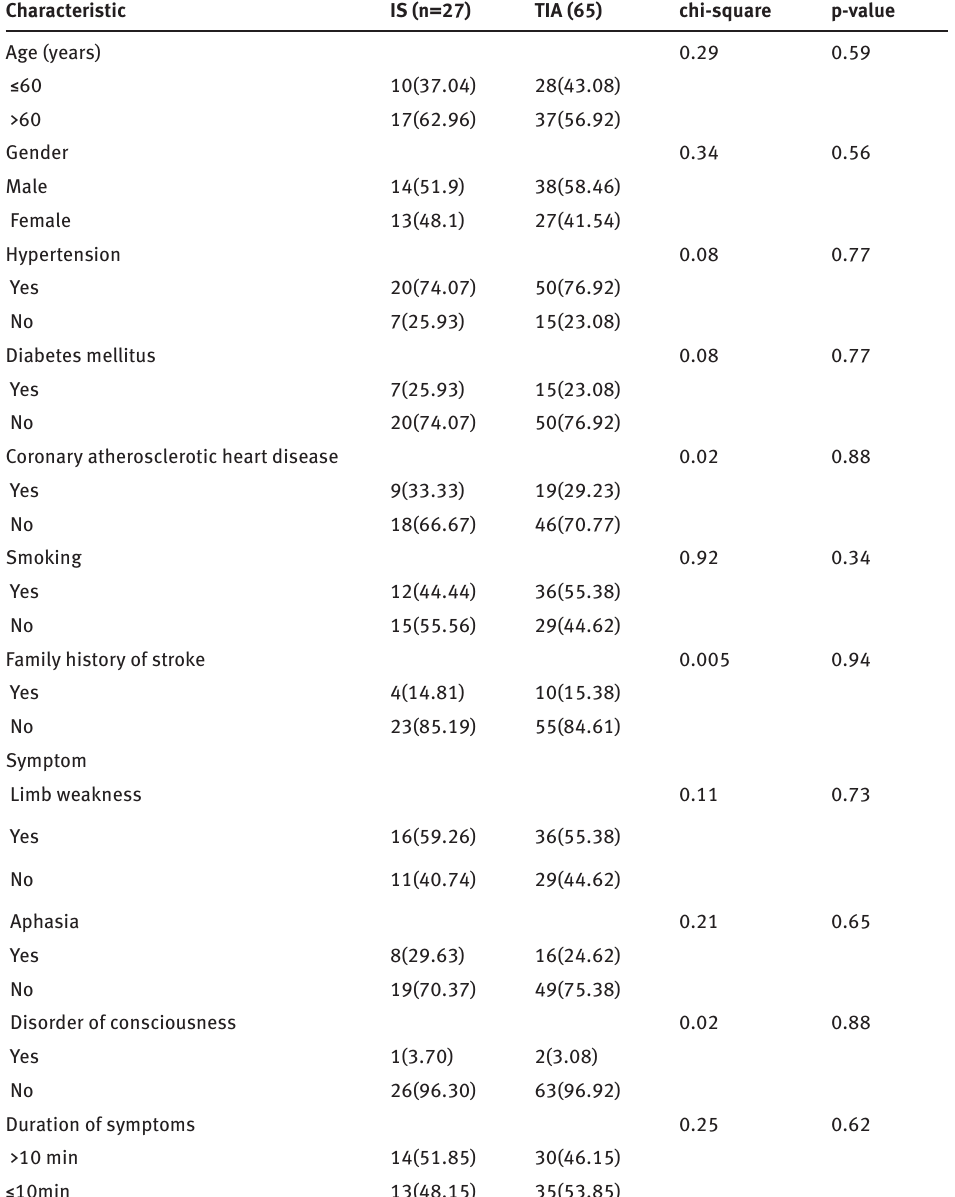
Table 1: The main characteristics of the included patients [n, (%)]. Characteristic